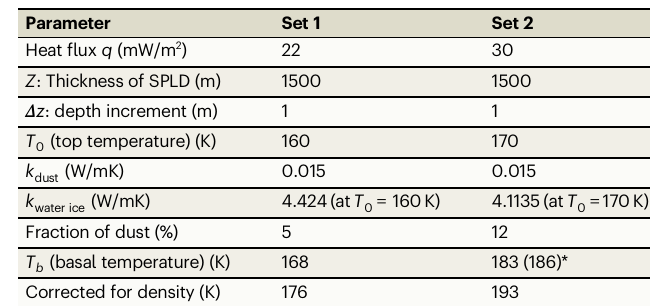
Table 1 | SPLD physical parameters for basal temperature